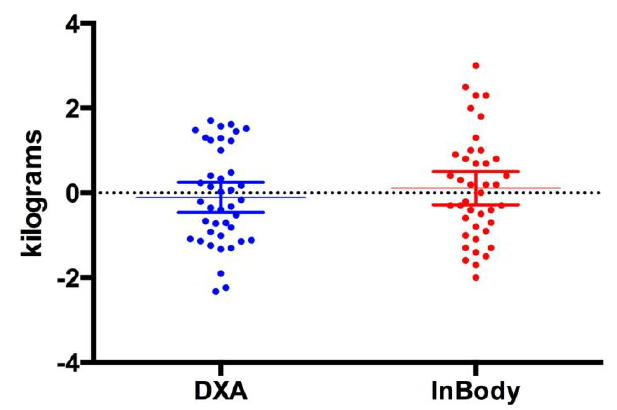
Figure 3. Change in Fat-free mass. This figure shows individual data points comparing the DXA vs. InBody BIA. The data is presented as the mean (middle horizontal line) with a 95% confidence interval (CI). DXA: Lower 95% CI of mean −0.4627, Upper 95% CI of mean 0.2505, InBody: Lower CI of mean –0.2841, Upper CI of mean 0.5037.